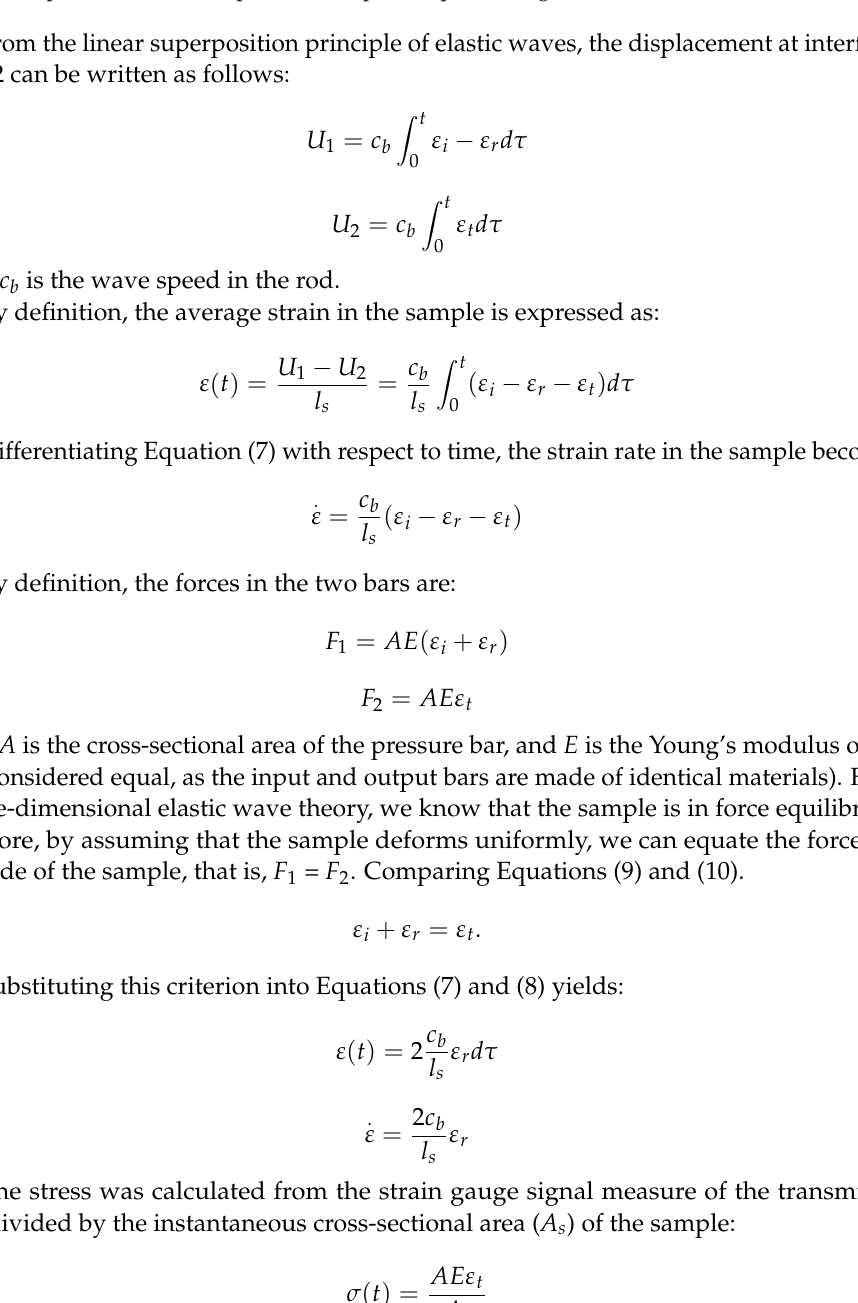
Figure 5. Expanded views of input bar/sample/output bar region.